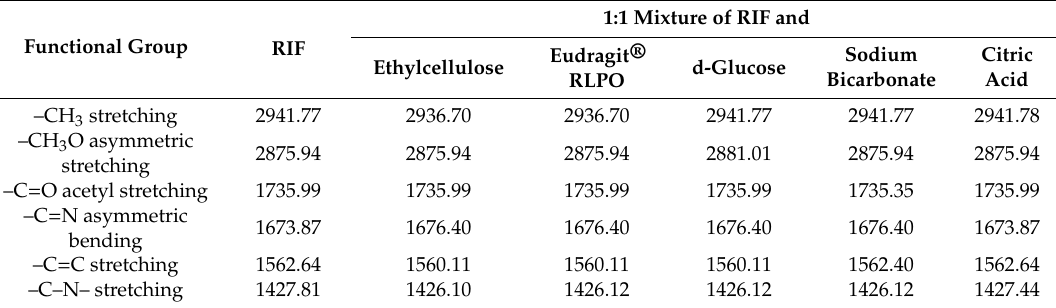
Table 4. FTIR wavenumber number assignments for RIF and 1:1 mixtures with excipients.